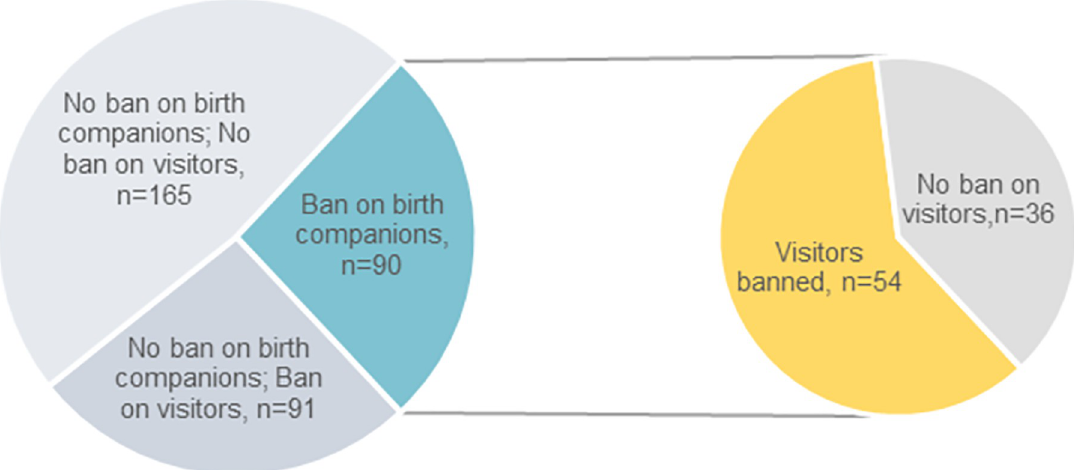
Fig 2. Breakdown of the number of respondents who mentioned that there was a ban on companionship during childbirth by their response regarding the ban on visitors in the postnatal period (n = 346).